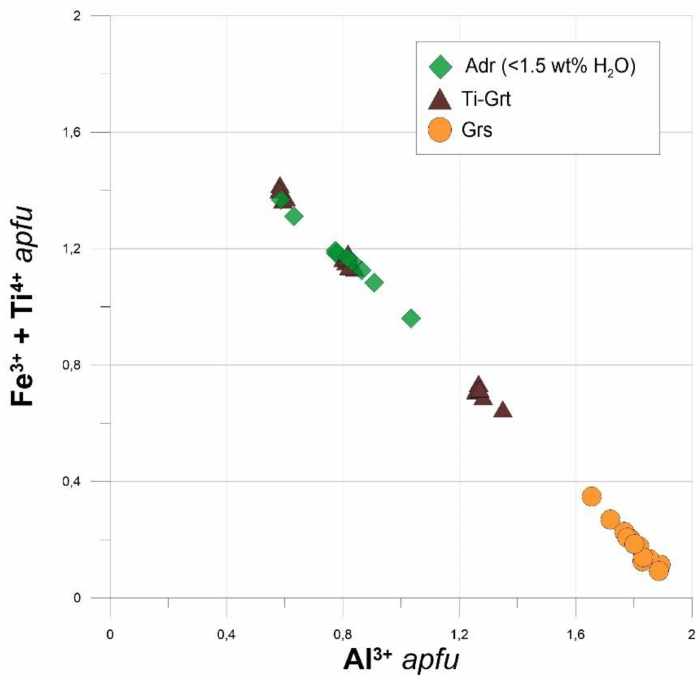
Figure 9. Garnet solid solution chemistry characterized by negative correlation between Al 3+ and Fe 3+ + Ti 4+ at Y crystallographic site.